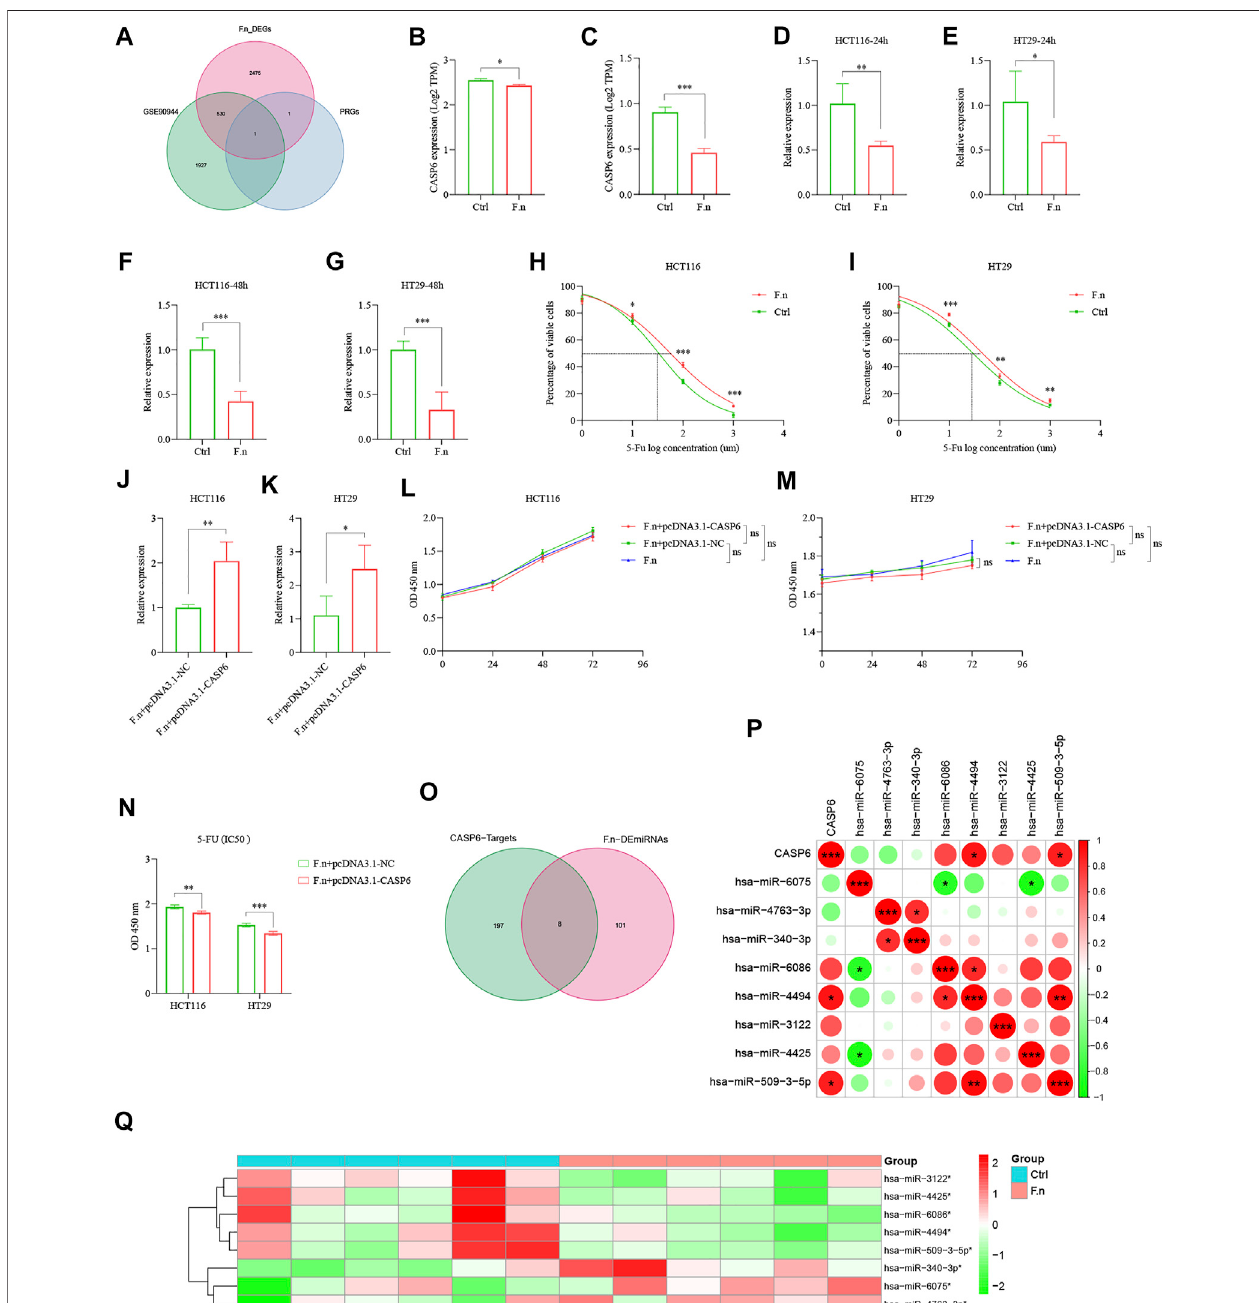
FIGURE 14 | F.n induces chemoresistance of CRC cells to 5-Fu via downregulation of CASP6 in vitro . (A) Venn diagram showed CASP6 shared by F.n -related DEGs and PRG signature. (B) Expression of CASP6 in GSE90944. (C) Expression of CASP6 between HCT116 cells and F.n -infected HCT116 cells using microarray analysis. (D – G) Expression ofCASP6 was quanti fi ed by qPCR in CRC cell lines infected with or without F.n for 24 and 48 h, respectively. (H,I) Cells were incubated with orwithout F.n andthenexposedtoserialdilutionsof5-Fufor48 h(cellviabilitywasdetermined byCCK8assay,anddataarepresentedasthepercentage ofviable cells). (J,K) RT – qPCR analysis of the CASP6 expression in CRC cell lines co-cultured with F.n for 24 h and then transfected with pcDNA3.1-CASP6 or empty pcDNA3.1 vector. (L, M) Cell proliferation was detected in HCT116 cells and HT29 cells after transfection with pcDNA3.1-CASP6 or empty pcDNA3.1 vector. (N) Cell viabilityofHCT116cellsandHT29cellsweredetectedusingaCCK8assayaftertransfectionwithaCASP6overexpressionvectorunder F.n treatmentfor24 h. (O) Venn diagram of differential miRNAs and possibly combined miRNAs with CASP6. (P, Q) Heatmap of signi fi cantly differential eight candidates ’ miRNAs (Q) and relationships between CASP6 and eight candidates ’ miRNAs (P). * p < 0.05; ** p < 0.01; and *** p < 0.001.